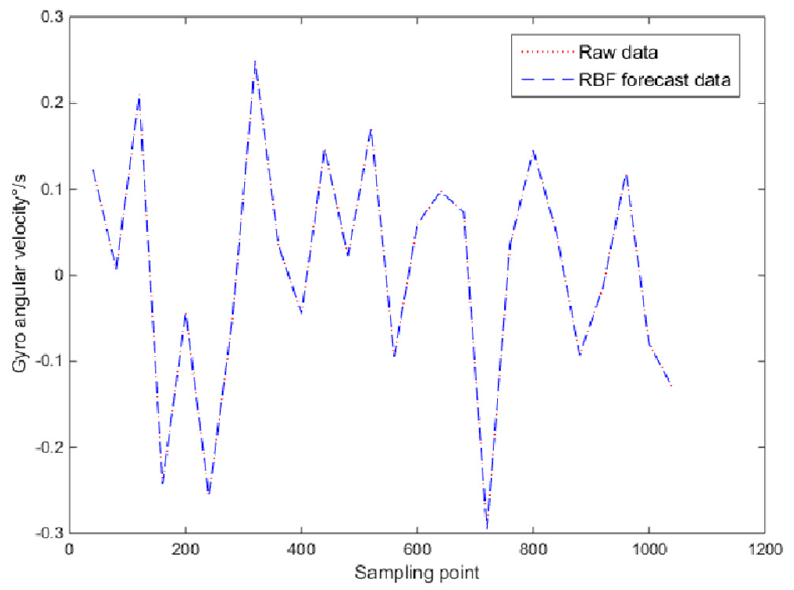
Figure 9. Raw signal and RBF prediction signal.